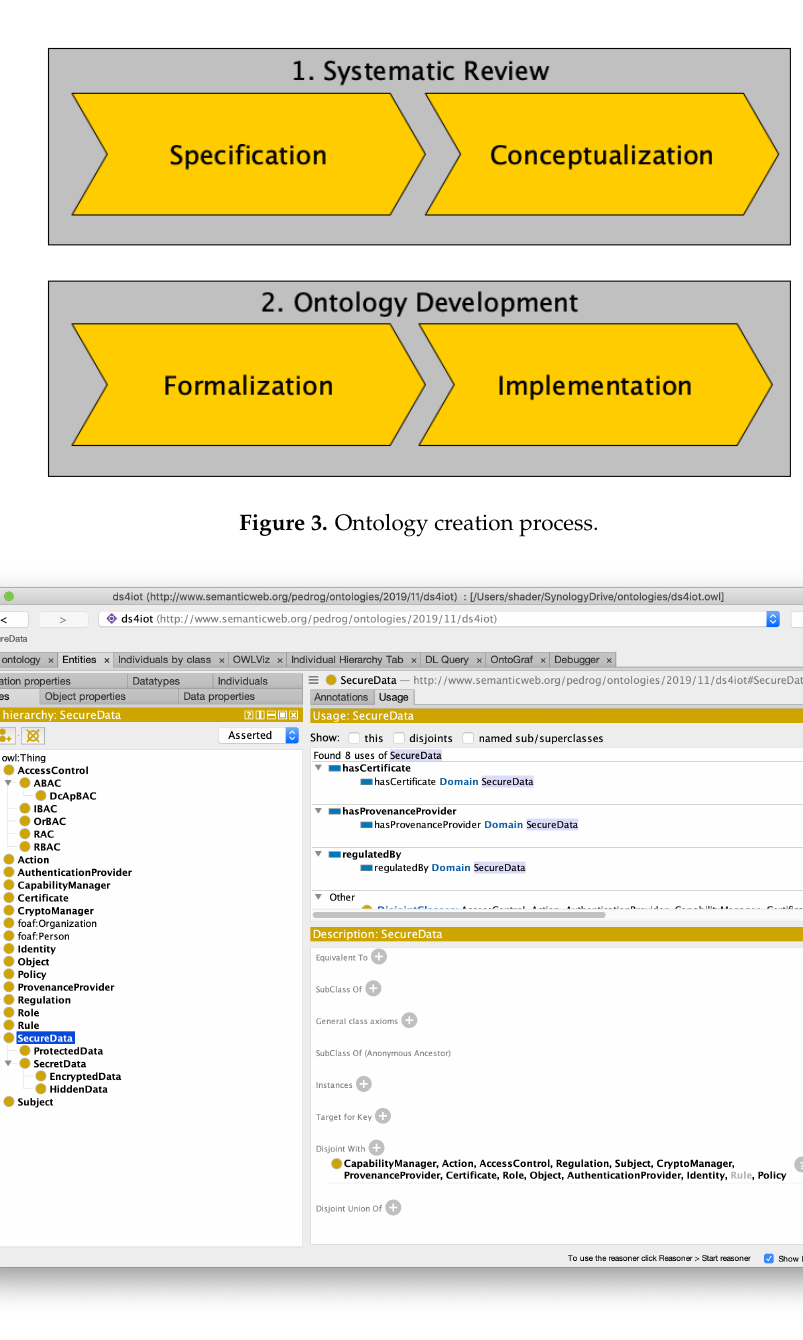
Figure 4. Protègè with DS4IoT